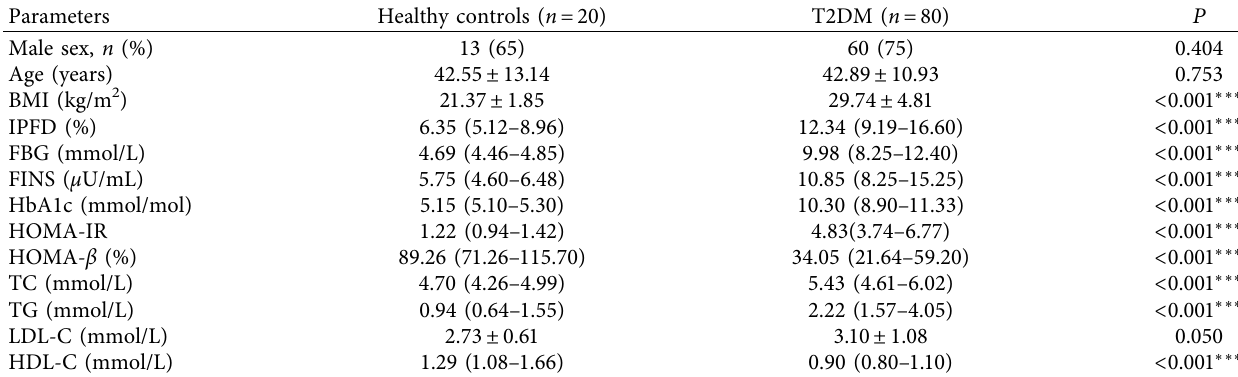
Table 1: Characteristics of study individuals.